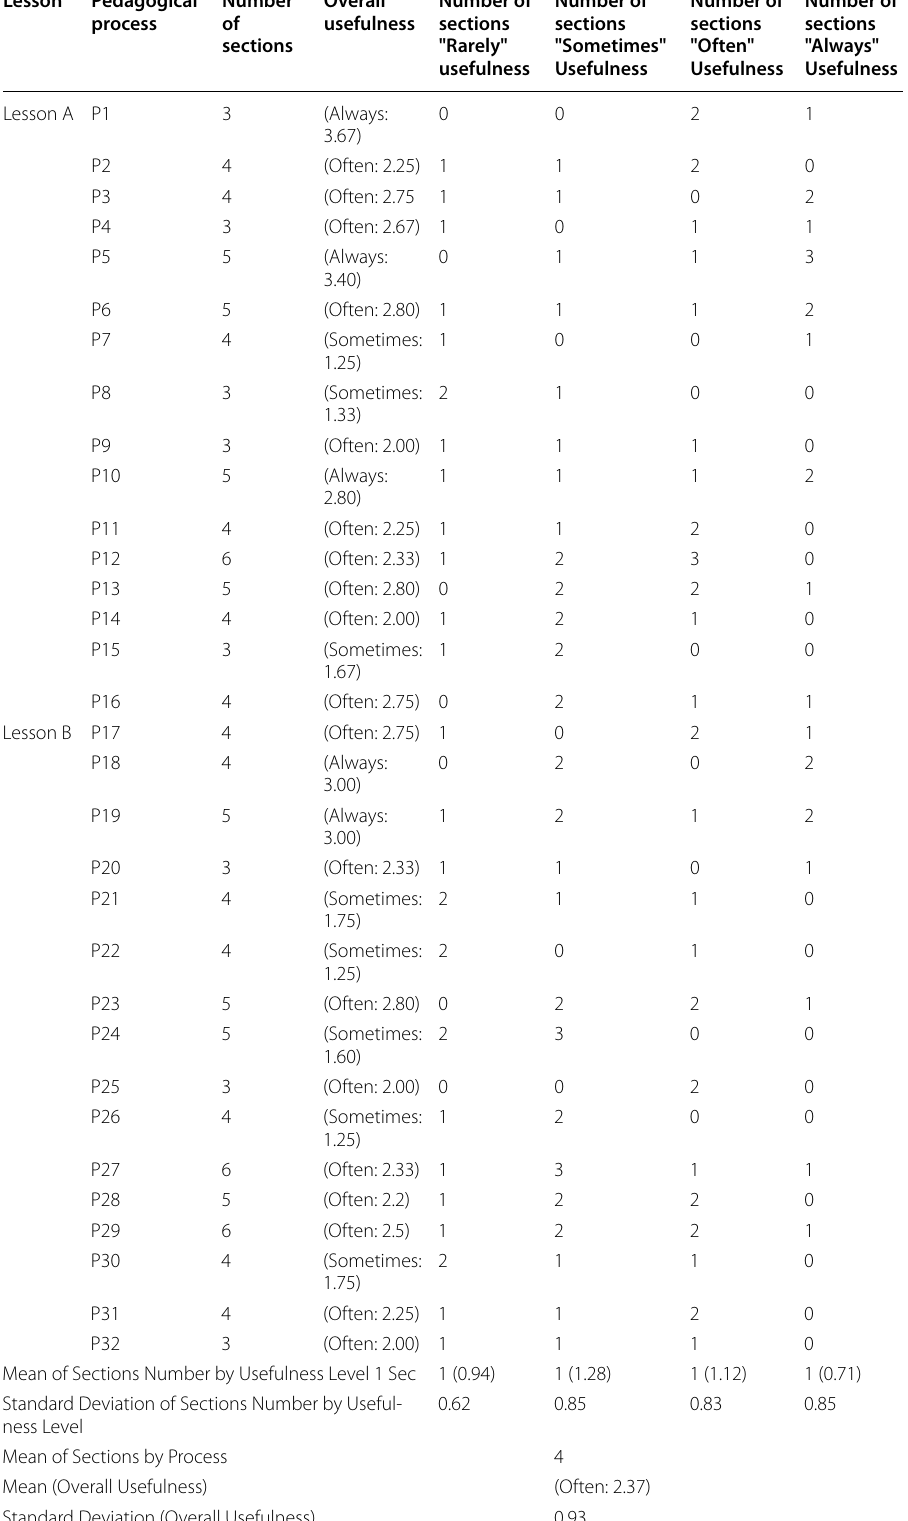
Table 2 Usefulness of pedagogical processes